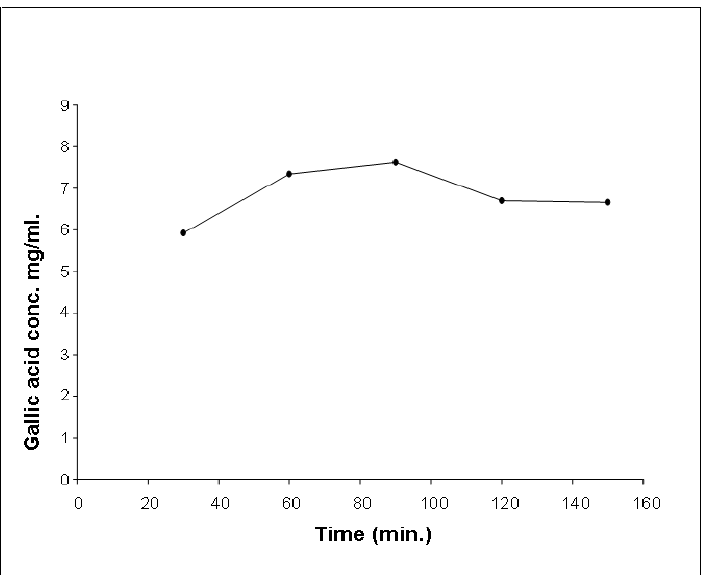
Figure 4. Gallic acid production at optimal